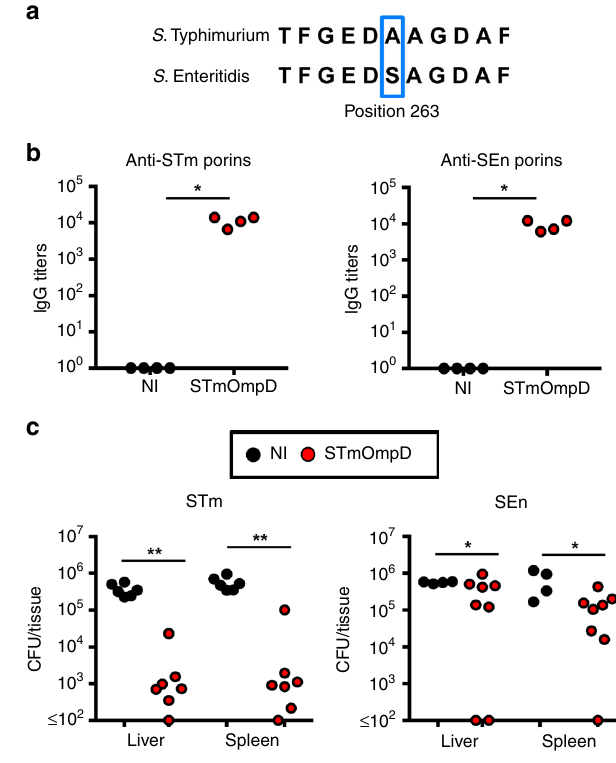
Fig. 2 Antibodies to STmOmpD offer limited cross-protection to SEn. a Alignment of OmpD sequences from STm and SEn showing the site where an alanine-to-serine substitution is observed at amino acid 263 of the whole sequence. b Serum IgG titers to STm and SEn porins from WT NI mice and mice immunized with STmOmpD as in Fig. 1a. Each point represents the titers from one mouse. Data representative of two experiments. c NI mice and mice immunized twice with 20 μ g of STmOmpD were challenged with 5 × 10 5 aroA − STm or SEn, and bacterial numbers per organ enumerated 3 days later. Each point represents the titers from one mouse. Data are representative of two individual experiments. * P ≤ 0.05, ** P ≤ 0.01 assessed by two-tailed Mann – Whitney U test.